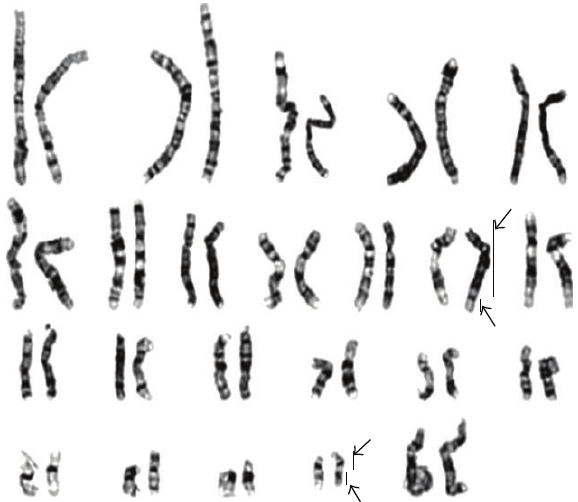
Figure 4: His mother’s karyotype shows a balanced non-Robertso- nian translocation between chromosome 11 and chromosome